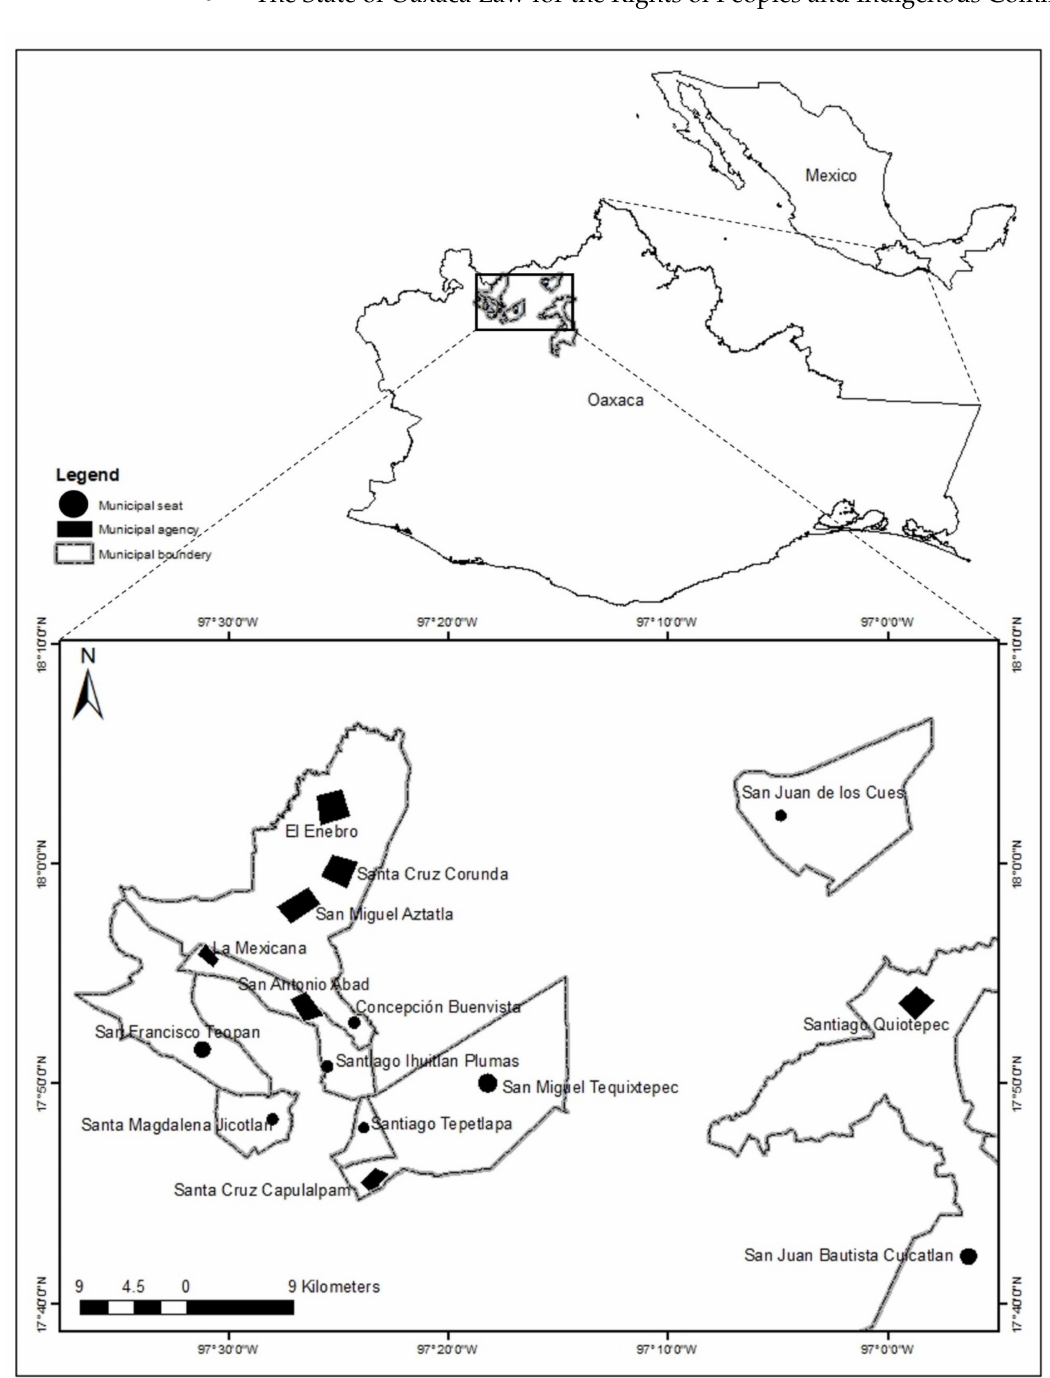
Figure 2. Macro- and micro-locations of the 13 rural communities in Oaxaca, Mexico, selected for this study. The map shows the political and administrative orders of the municipalities (dotted line), municipal seats (circles), and municipal agencies (rectangles). Municipalities are named after their municipal seats. Source: Prepared by the authors from governmental vector